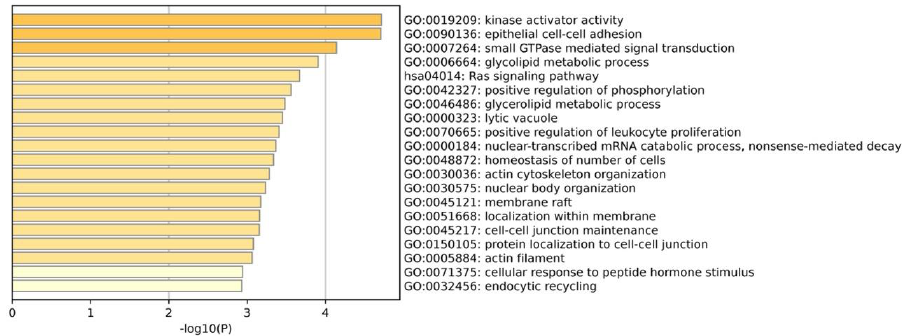
Figure 3. Bar graph of 20 functional enrichment categories analyzed using Metascape.